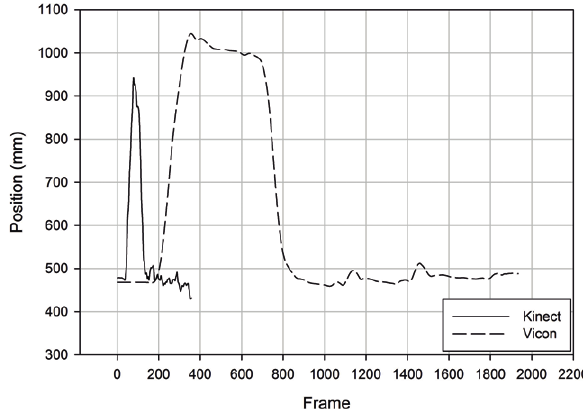
Fig. 3: Coordination graph of right knee in the z direction before synchronization and matching coordinate origins of the Kinect and Vicon system. Fig. 4: Graph of center of mass which Vicon data were not complete